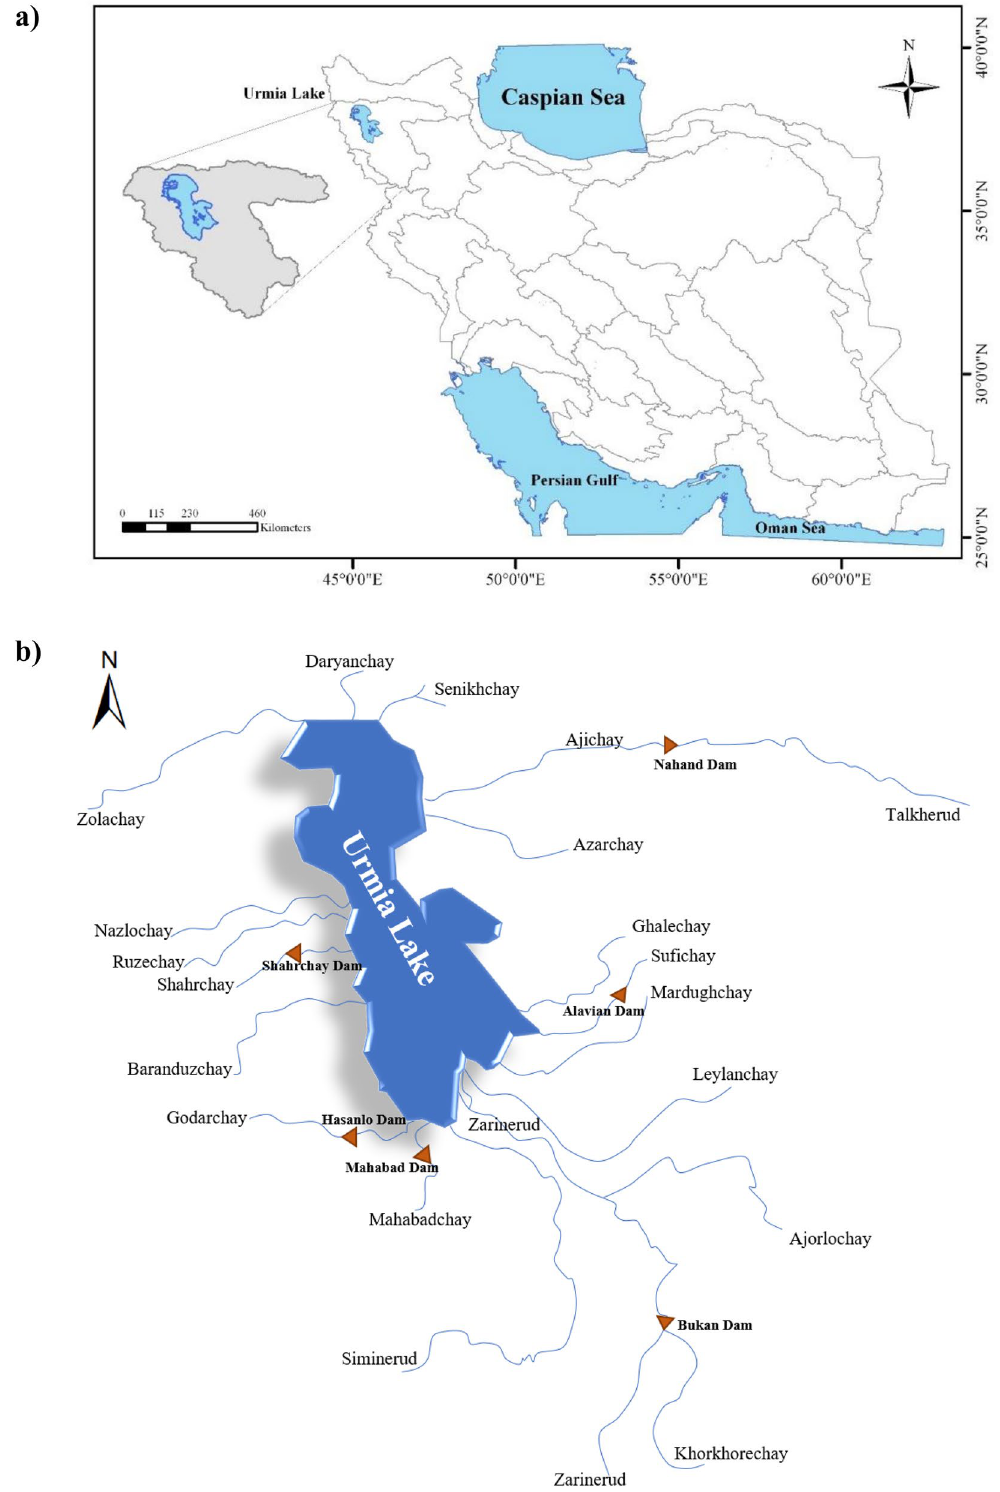
Figure 1. Case Study ( a ) Location of the Lake Urmia basin; ( b ) Schematic of the river drainage network in the Lake Urmia basin. Not drawn to